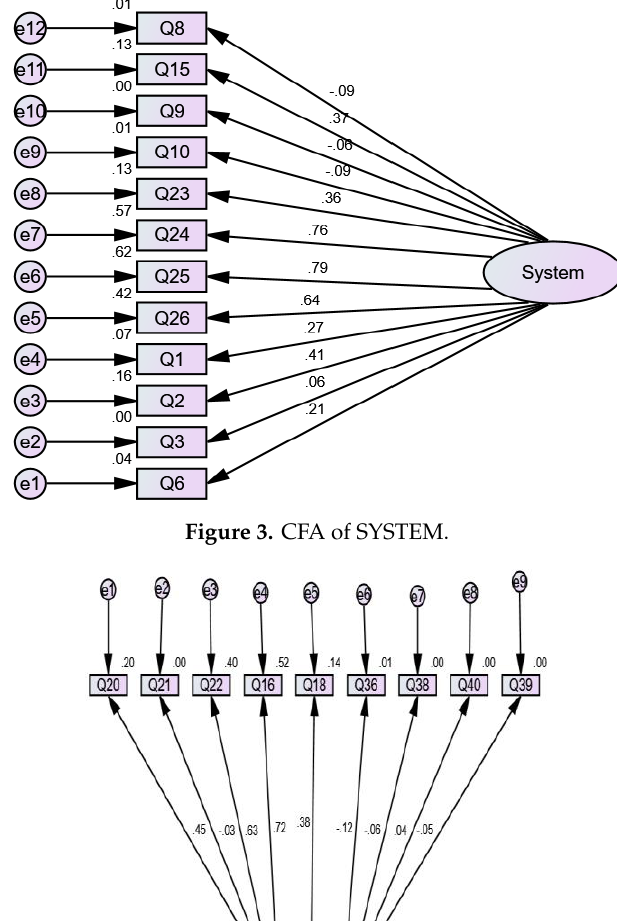
Table 2. Cronbach’s Alpha for the overall questionnaire. Table 4. Confirmatory factor analysis of SYSTEM.